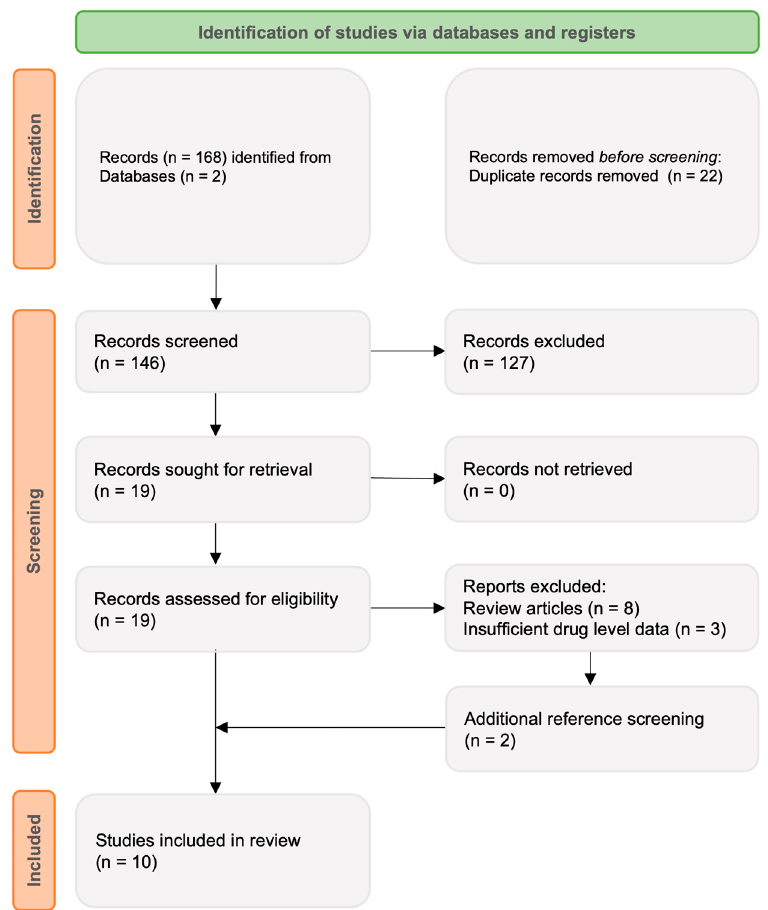
Figure 1. Search strategy outlining screening and eligibility assessment.